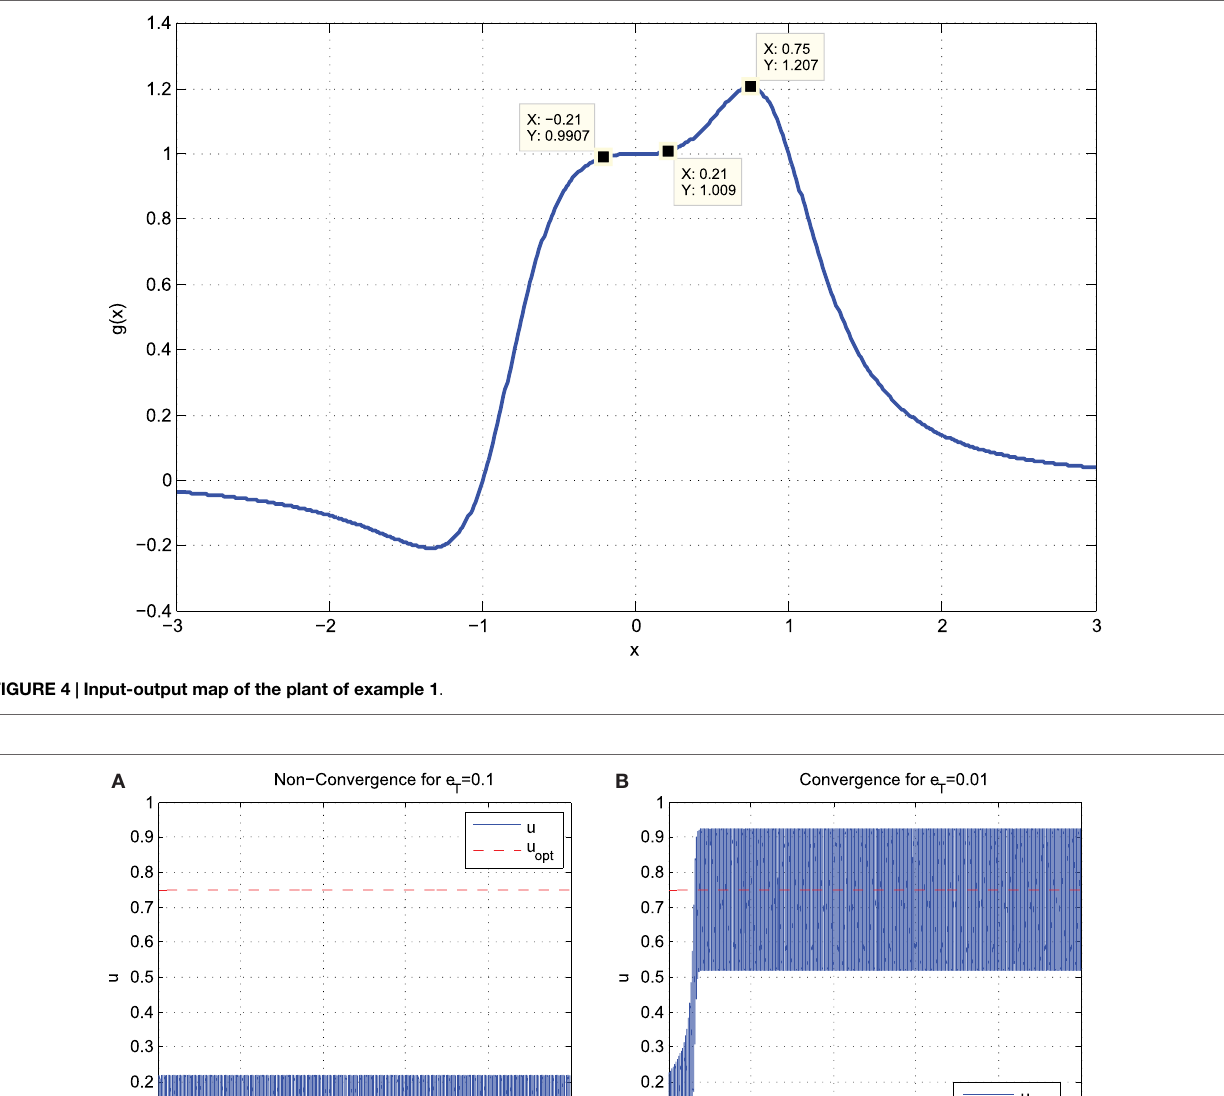
FIGURE 5 | MBET encoded ESC performance for the plant of example 1 . (A) Non-convergence for e T =0.1. (B) Convergence for e T =0.01.